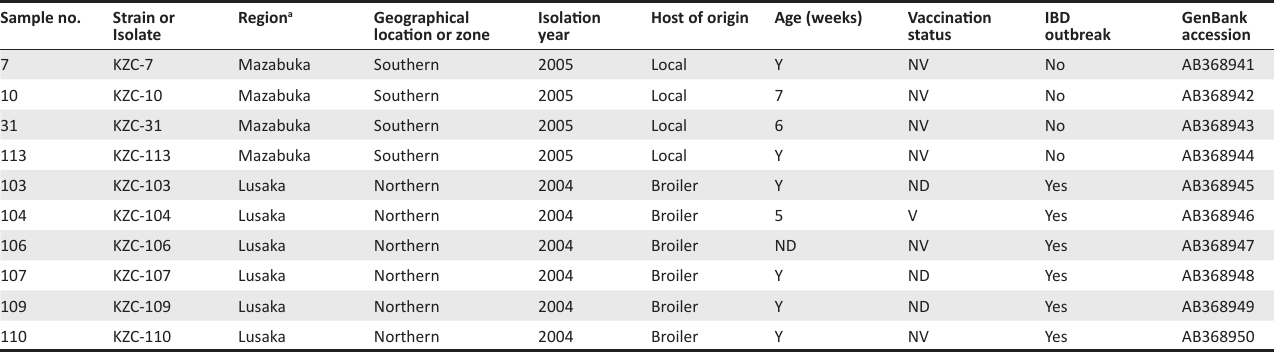
▲ , indicate areas where IBDV isolates were detected; cross, indicates north. FIGURE 1: Map of Zambia showing geographic origins of the Zambian IBDV field isolates examined in this TABLE 1: Description of infectious bursal disease virus strains used in this study. Sample no.